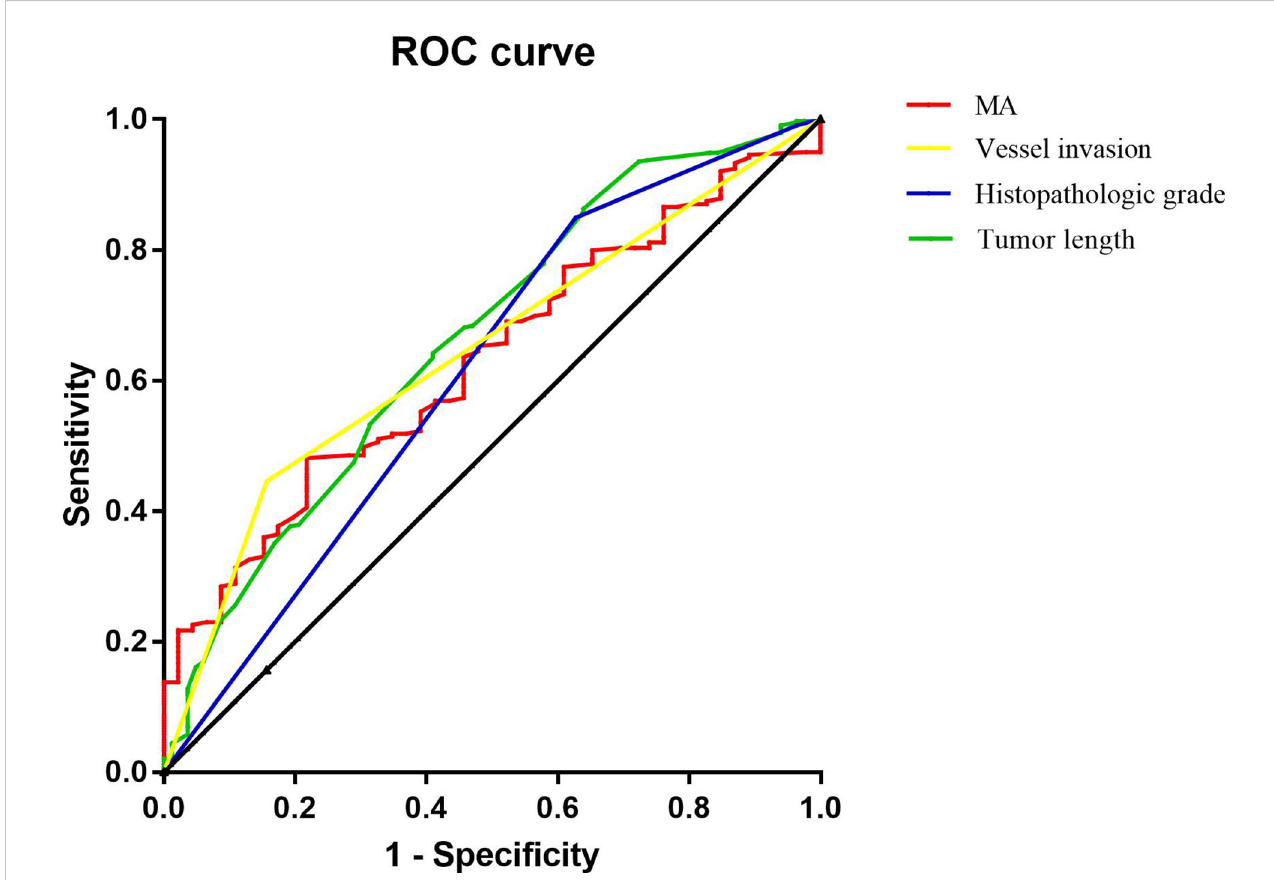
FIGURE 4 Figure of ROC analysis results of tumor length, histopathologic grade, vessel invasion and MA for predicting the lymph node metastasis of gastric cancer.